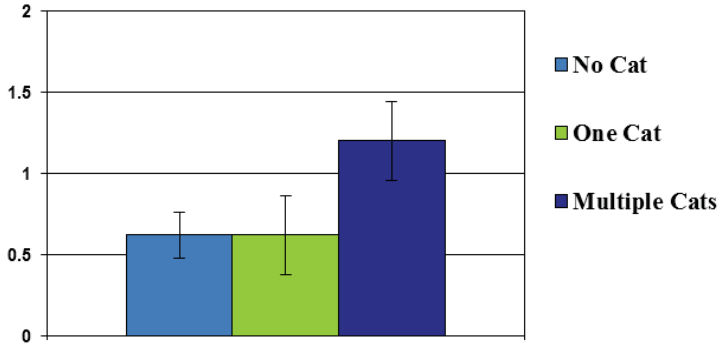
Figure 3. Difficulty evacuating among non-cat owners, owners of one cat, and owners of multiple cats.